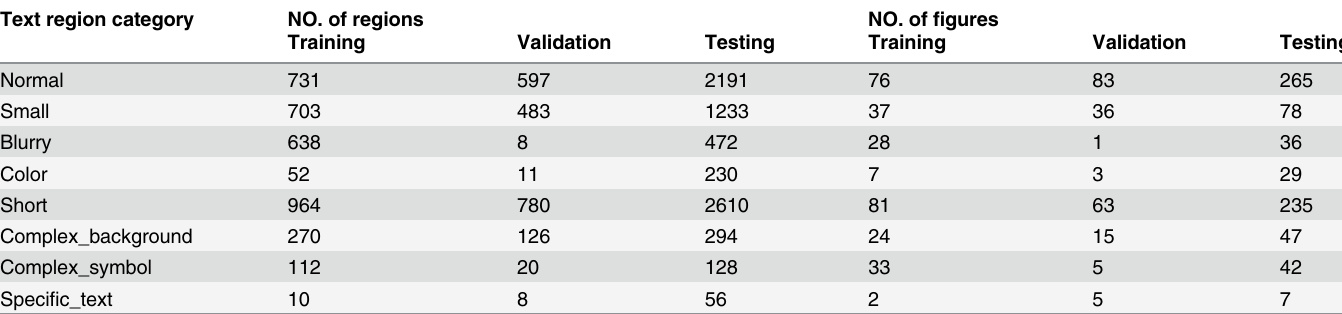
Table 7. Statistics of text regions and figures with different categories on the training, validation, and testing